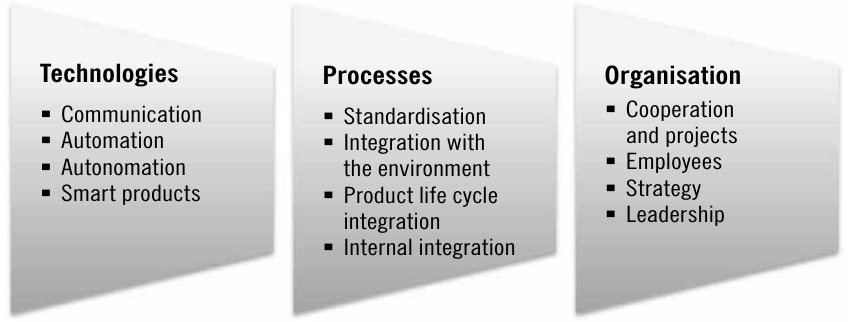
Figure 2. Model of digital maturity in Industry